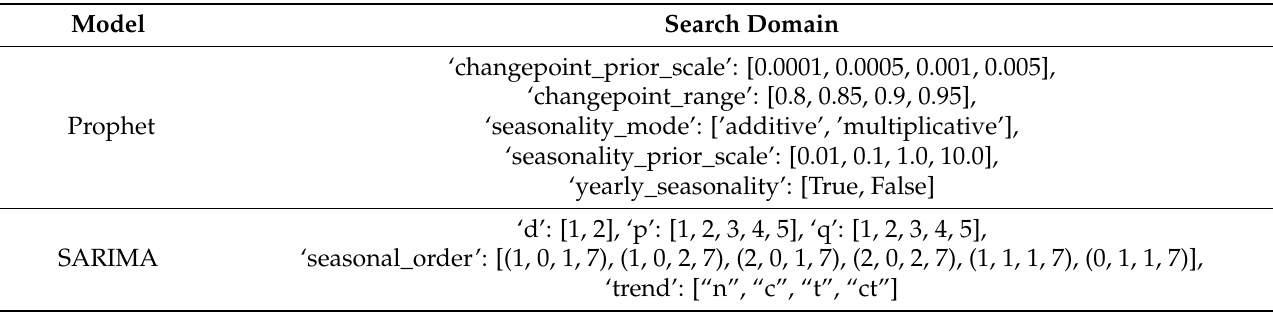
Table A1. Hyperparameter search domain for the Prophet and SARIMA models.